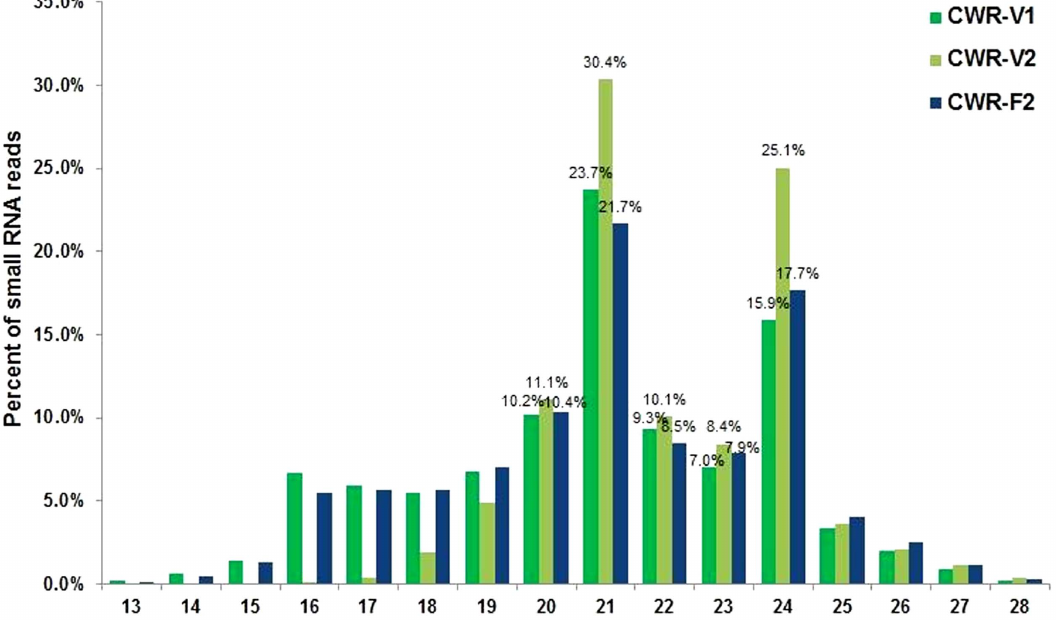
Figure 1. Length distribution of sRNAs in the three libraries at different developmental stages.